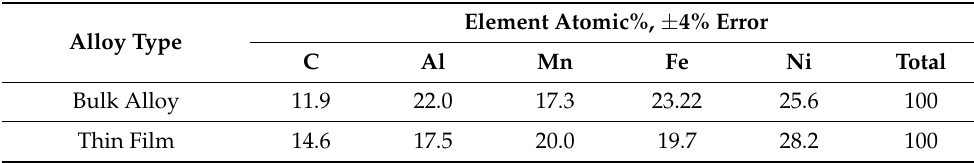
Table 2. The chemical compositions for bulk and thin films alloys.